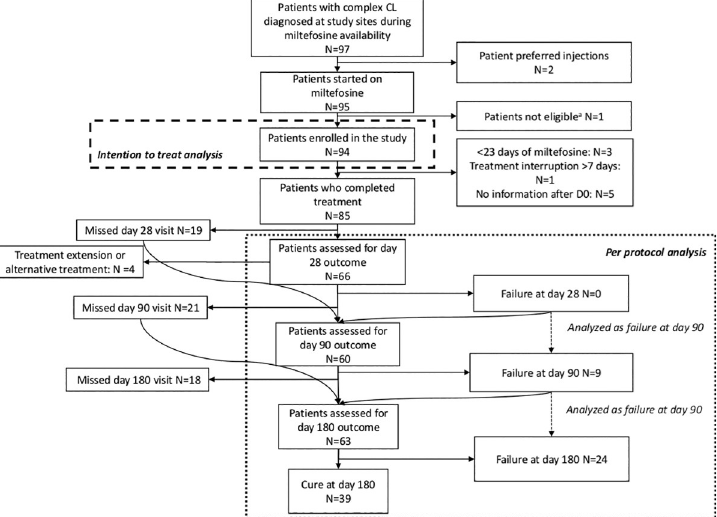
Fig 1. Flow chart of patients. a We initially only planned to include microscopy confirmed patients, but due to the high proportion of patients treated empirically, we amended the inclusion criteria. One patient treated empirically was excluded because at the time of starting miltefosine, the amendment was not yet